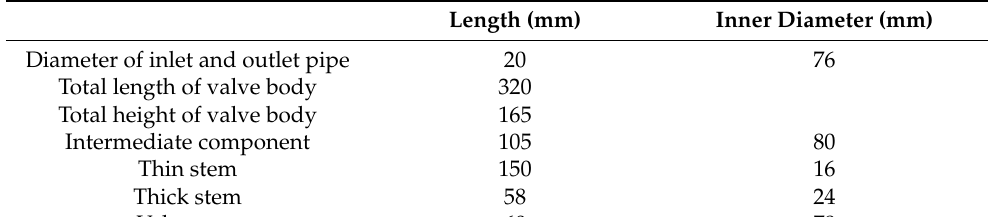
Table 4. Data sheet of regulating valve sizes.